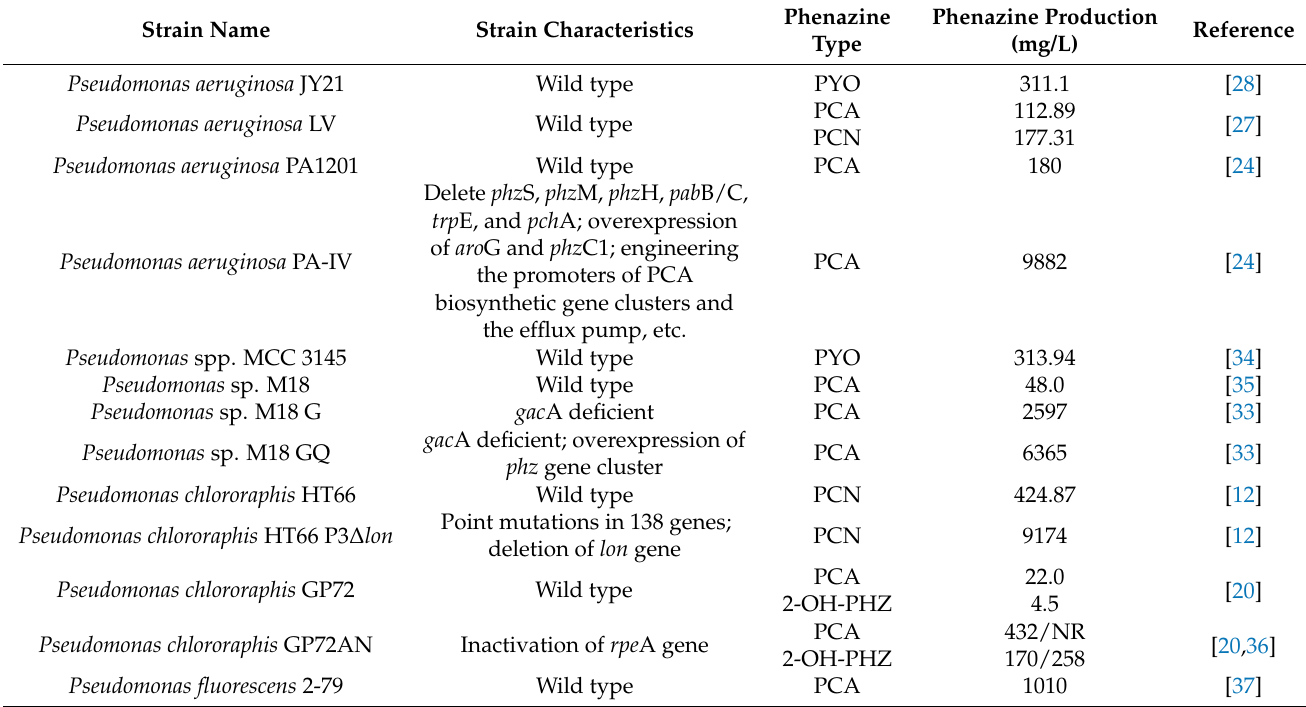
Table 2. Phenazine production by Pseudomonas sp., including phenazine type and the amount